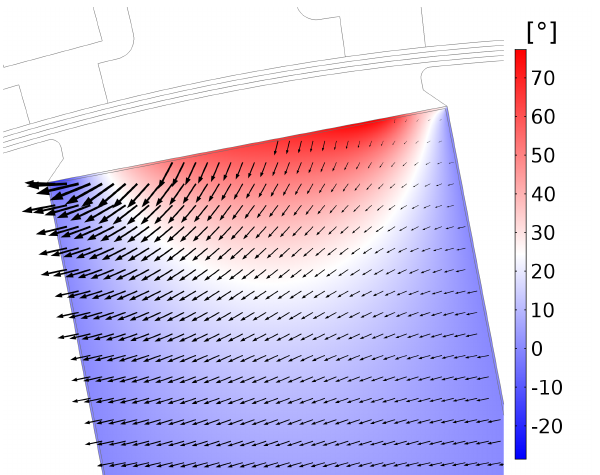
Figure 12. Vector plot (arrows) and the inclination angles (colored) for the magnetic field strength H in a PM for one rotor position with a current density J rms = 4 A/mm 2 . The maximum inclination angle and maximum magnitude appear on opposite sides of the PM boundary towards the air